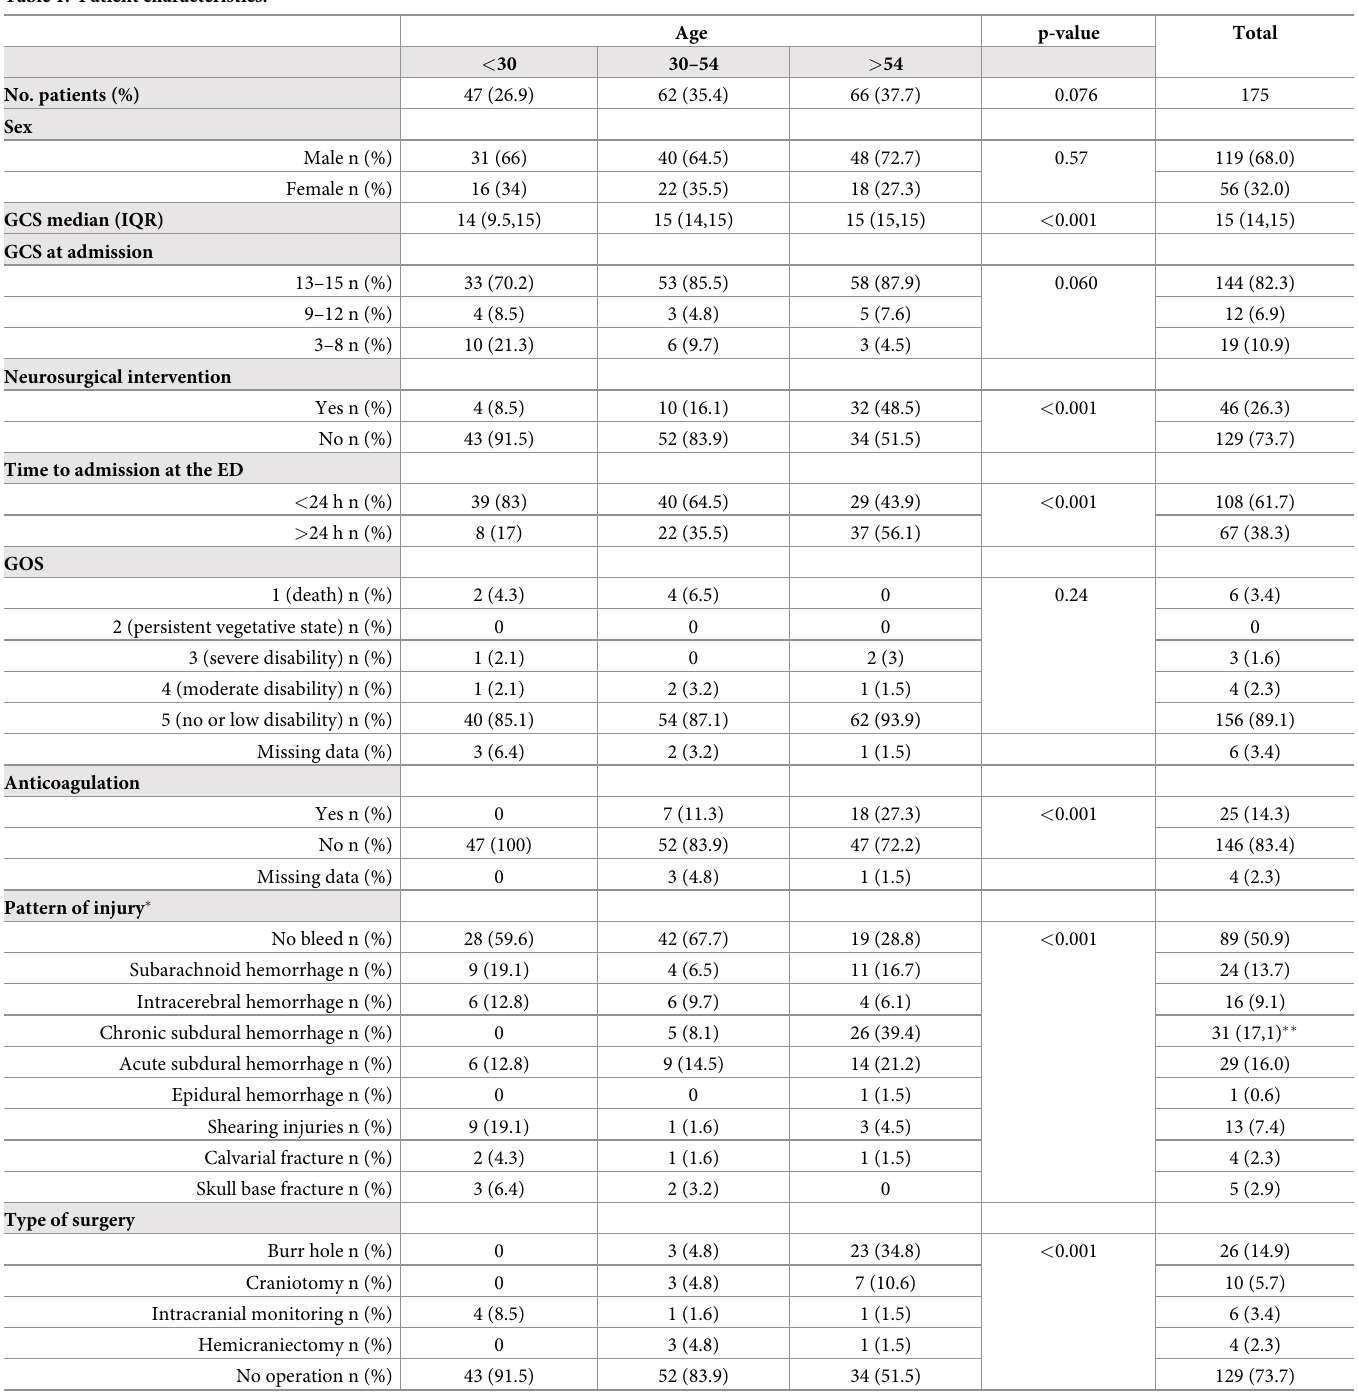
Table 1. Patient